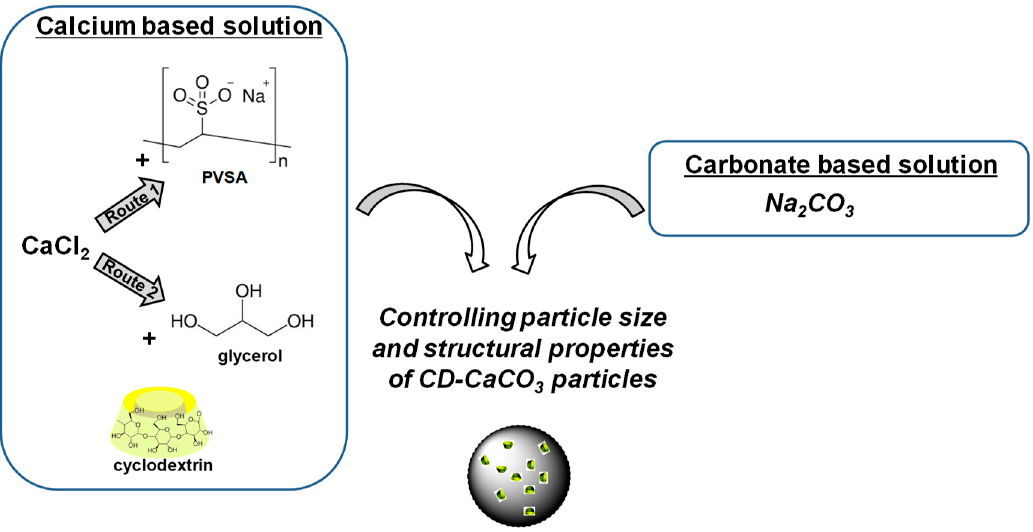
Figure 1. Scheme showing the process of fabrication of CD-calcium carbonate particles in presence of additive. of